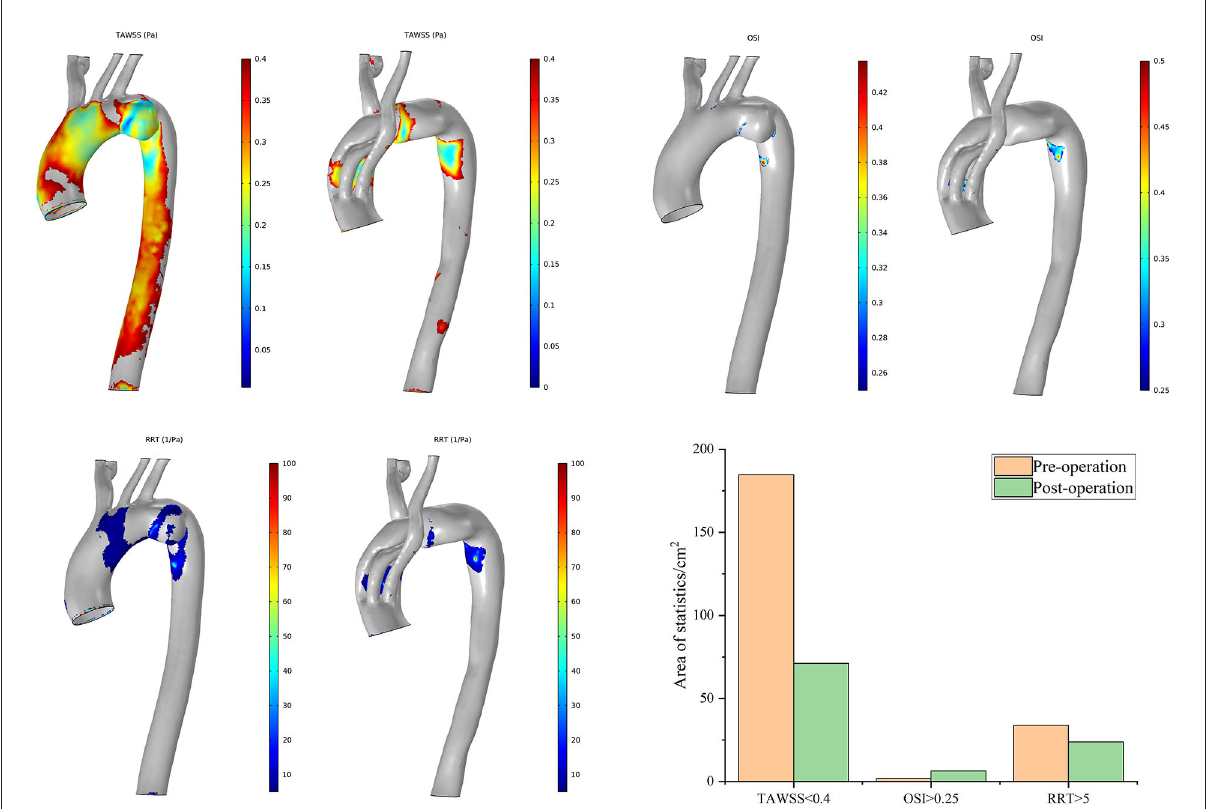
FIGURE9 Distributions of changes in TAWSS, OSI, and RRT in Case 7. The hemodynamic characteristic regions are visually illustrated as a color distribution nephogram with each indicator in a group (left, preoperative; right, postoperative). Areas were calculated and illustrated in the bar graph. OSI, oscillatory shear index; RRT, relative residence time; TAWSS, time-averaged wall shear stress.